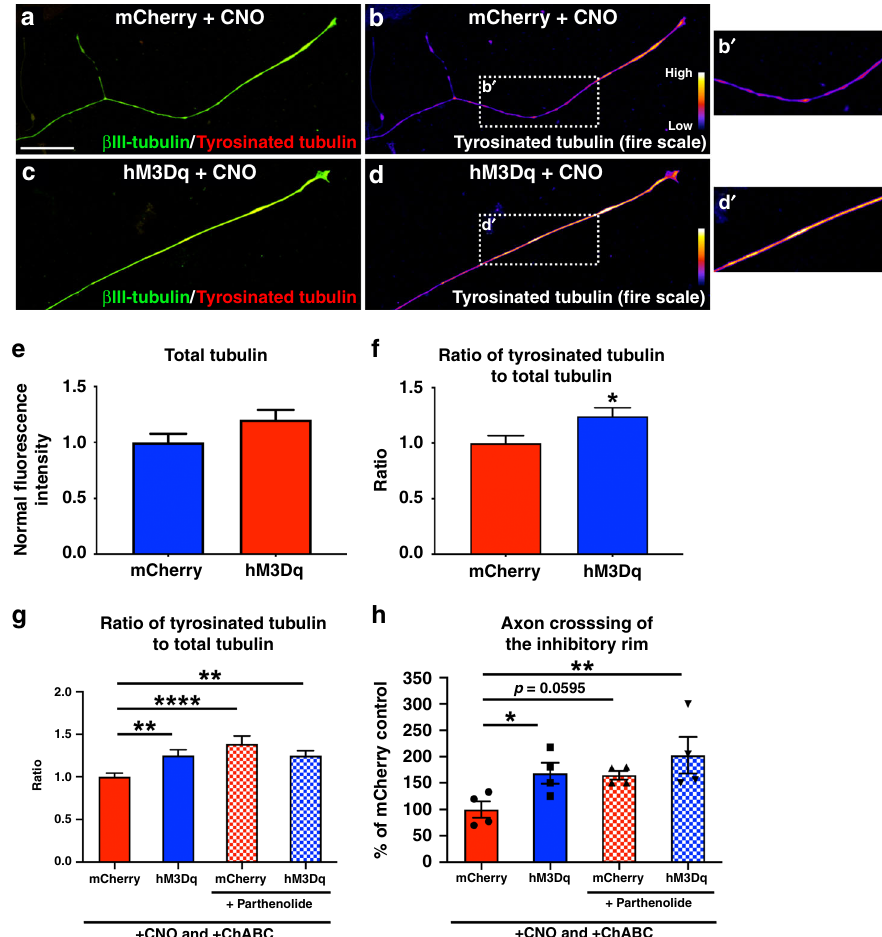
Fig. 9 Chemogenetic activation of DRGs increases the ratio of tyrosinated to total tubulin in the distal axon to improve growth on inhibitory substrates. a – f Representative images of the distal-most portion of axons from mCherry + ( a , b ) or hM3Dq + ( c , d ) DRGs stained for β III-tubulin (green) and tyrosinated tubulin (red in a , c ; standard fi re scale pseudo-color in b , d ) 24 h after replating and CNO treatment. There was no difference in the fl uorescence intensity for β III-tubulin in the distal-most 50 µ m of axons growing from mCherry + neurons and chemogenetically activated, hM3Dq + neurons ( e ). However, the ratio of tyrosinated tubulin to total β III-tubulin was higher in the axons from CNO-activated, hM3Dq + DRG neurons ( f ), indicating an increase of labile microtubules in axons extending from chemogenetically-activated neurons. g , h Cultures of mCherry + or hM3Dq +